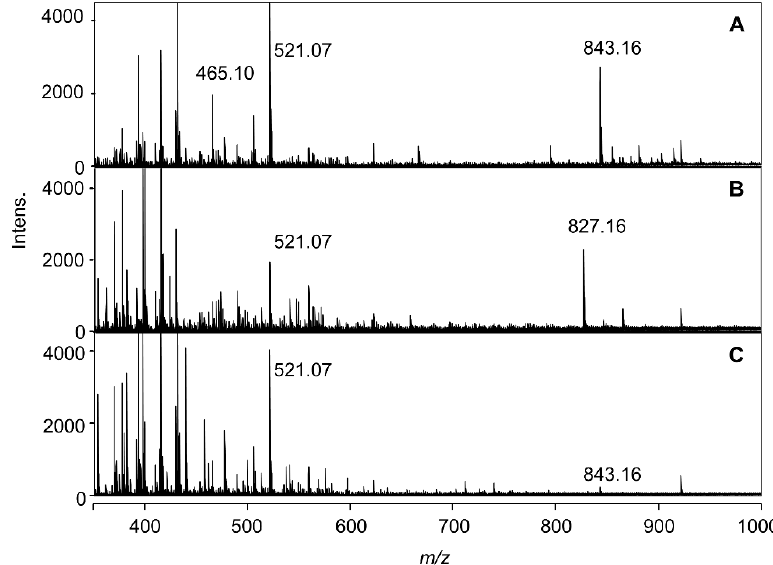
Figure 3. Positive detection ESI-TOF-Mass spectra of reproduced solutions formed by mixing 1 (Dp3G, 0.1 mM) and Al 3+ (1 eq.) with 2 eq. of co-pigment, 5CQ ( 2 ), 5 p CQ ( 3 ), or 3CQ ( 4 ) in buffered solutions at pH 4.0 (2 mM). ( A ) 5 CQ ( 2 ). ( B ) 5 p CQ ( 3 ). ( C ) 3 CQ ( 4 ).